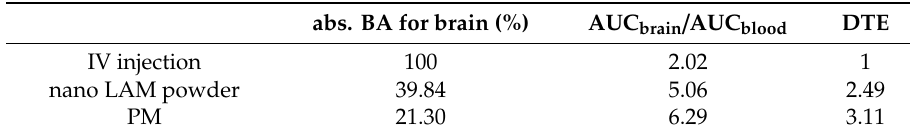
Table 3. Calculated parameters of intranasal powders applying IV administration as a benchmark. AUC: Area under the